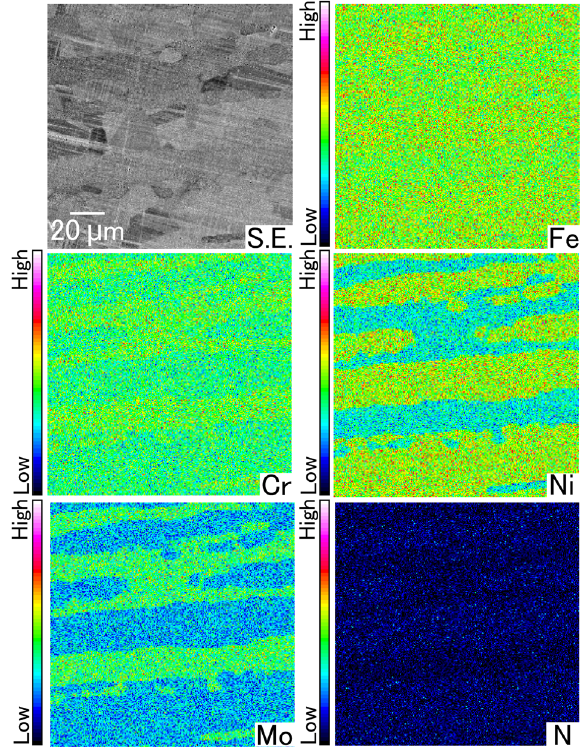
Fig. 2 SEM image and EPMA maps of the solution-treated specimen. The observation was conducted in the area demarcated by the dashed broken square in Fig. 1.